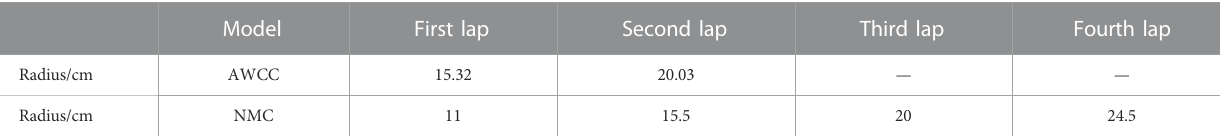
TABLE 1 Radius of each circle of AWCC and NMC probe tubes.